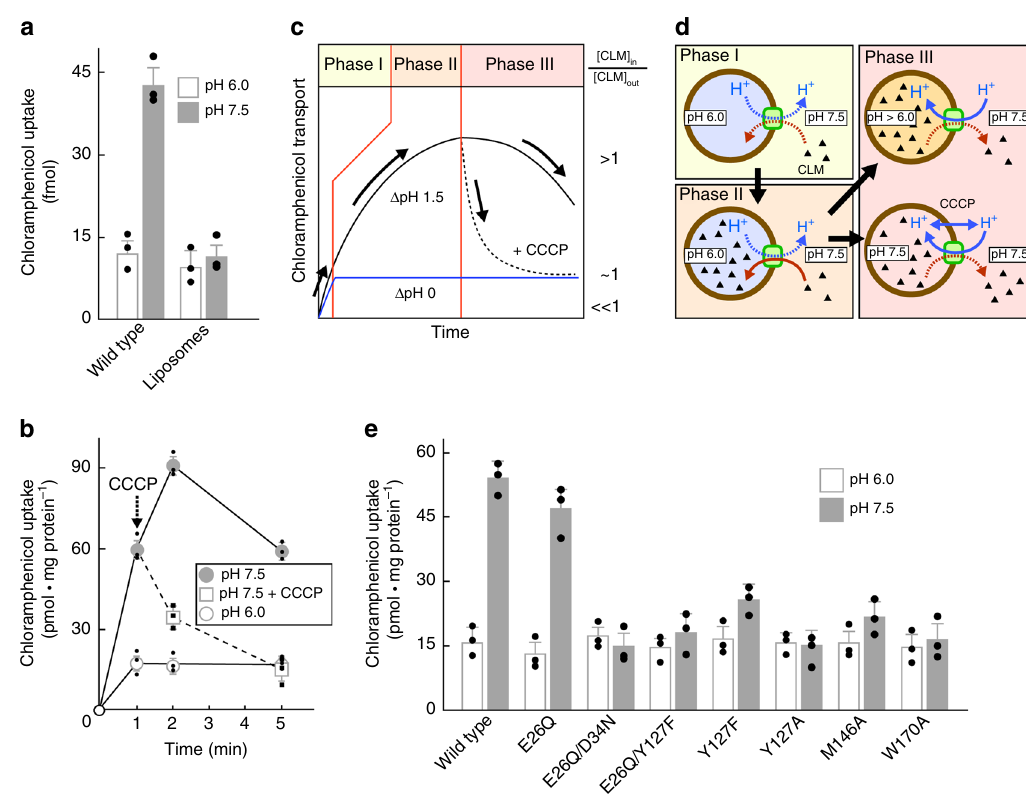
Fig. 4 Chloramphenicol transport by MdfA reconstituted in proteoliposomes. a Chloramphenicol transport into reconstituted proteoliposomes is dependent upon the presence of MdfA and a pH gradient. b Time course for uptake using reconstituted MdfA. In the absence of a pH gradient (open circles), downhill-like transport (with the substrate gradient) occurs rapidly due to the small volume of the proteoliposomes. In the presence of a pH gradient, however, chloramphenicol uptake ( fi lled circles) involves at least three phases: following a rapid initial downhill transport phase (not visible), uphill accumulation of the substrate in the liposomal lumen against the concentration gradient takes place at the expense of proton export (II). Within a few minutes, the situation is reversed due to lumen acidi fi cation, leading to chloramphenicol ef fl ux (phase III). Crucially, collapse of the pH gradient through administration of the H + -ionophore CCCP (open squares) results in rapid chloramphenicol ef fl ux (downhill transport) until the luminal concentration reaches that observed in the absence of a pH gradient. c , d Schematic diagram illustrating the phases of chloramphenicol (CLM) uptake in the reconstituted system. e Uptake by proteoliposomes containing puri fi ed MdfA variants in the presence (closed bars) and absence (open bars) of a pH gradient at 1 min. Data are mean values± s.d., n = are closed. Analysis of the free energy landscape for this transition (Supplementary Fig. 5a) indicates that upon protonation of Asp34 TM1 , the O o state is much less stable than the occluded